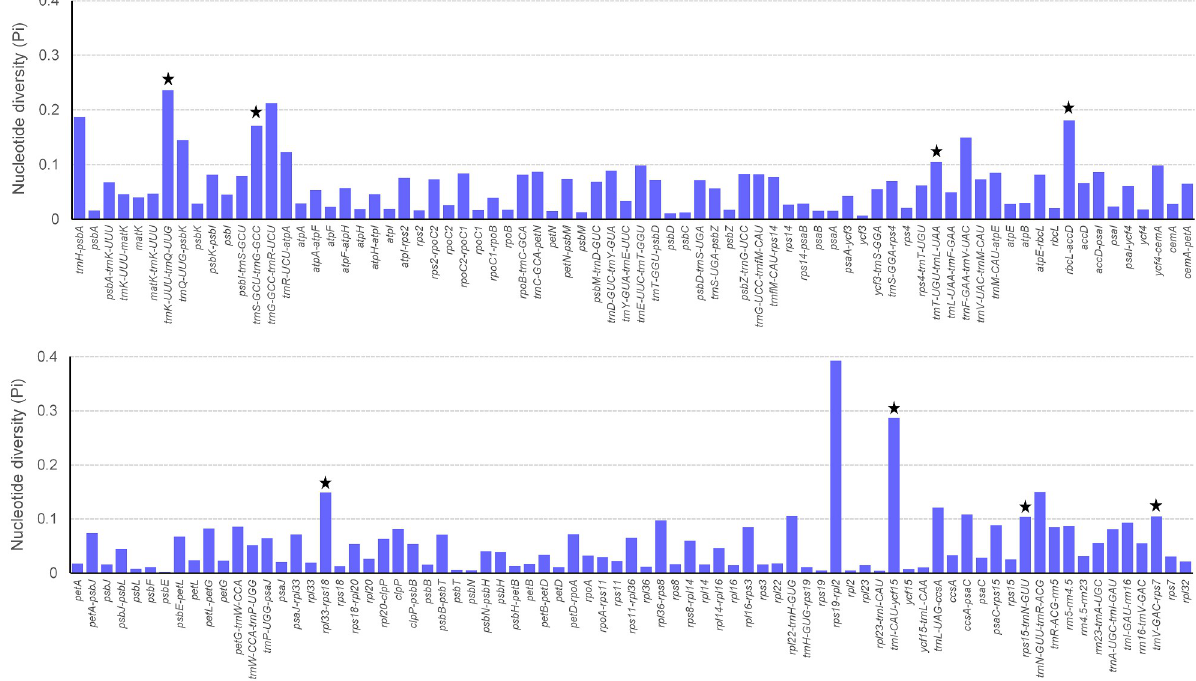
Fig 4. The nucleotide diversity values (Pi) of all regions. Regions with Pi = 0 are excluded and are not exhibited in the figure. The black starts show 8 polymorphic loci with the length > 300 bp and Pi > 0.1. The X-axis indicates chloroplast regions and the y-axis nucleotide diversity values (Pi).